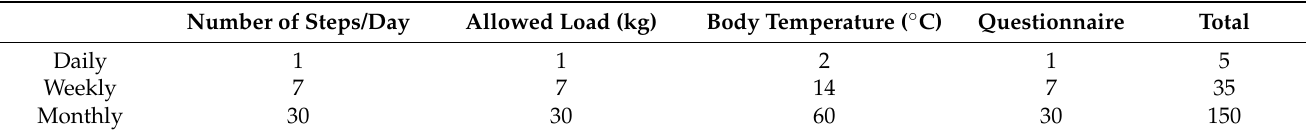
Table 1. Number of measurements requested from each patient in the first